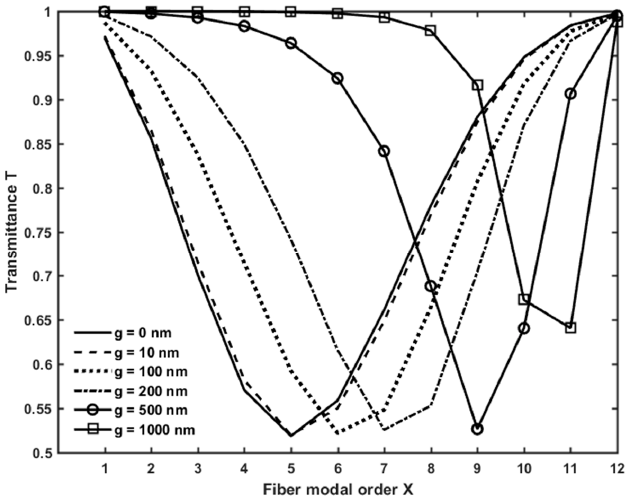
Figure 4. Transmitted power of the microsphere-based setup, calculated for different gap values, ranging from g = 0 nm to g = 1000 nm.